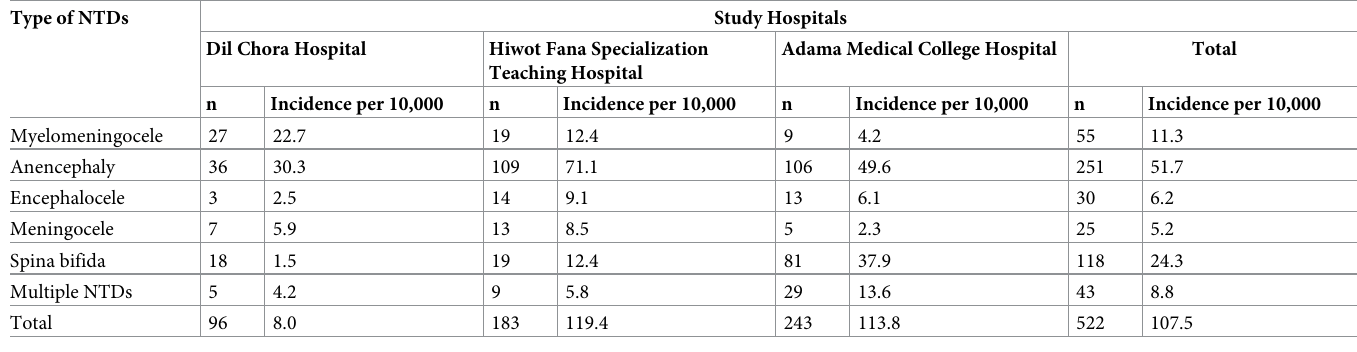
Table 7. Incidence of type of NTDs among study hospitals Eastern Ethiopia, data from 2017–2019. Type of